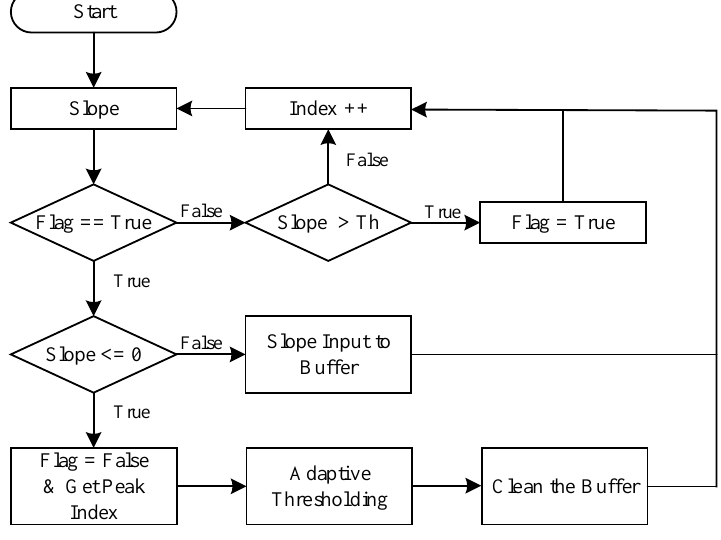
Figure 4. The peak detection flow, adapted from